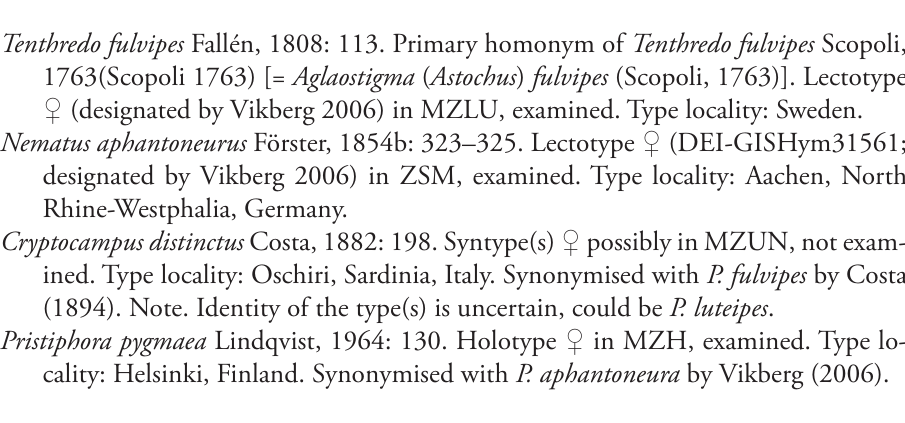
Tenthredo fulvipes Fallén, 1808: 113. Primary homonym of